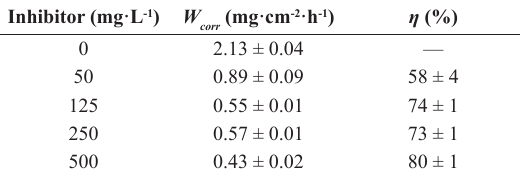
Table 3: C‑steel weight loss data in 1.0 mol L -1 H without methanolic Bauhinia purpurea leaf extract at the following concentrations: 50, 125, 250 and 500 mg L -1 .